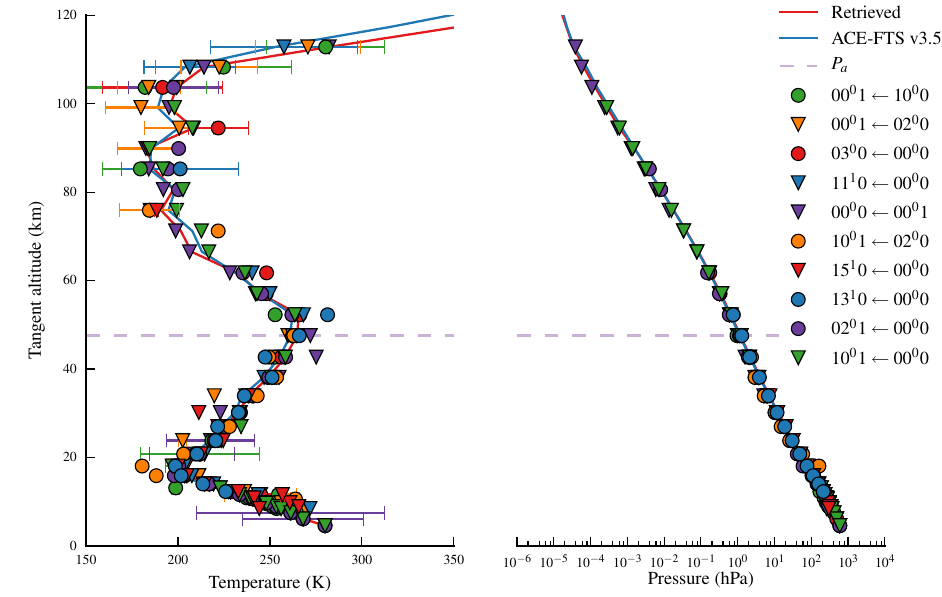
Figure 2. Retrieved T and P using all CO 2 bands at all tangent altitudes for ACE-FTS occultation ss5211. Each marker indicates a band that passed data quality criteria; no bands contribute at every altitude. The retrieved pressure profile (red line) is that computed from Eq. (6) by integrating the retrieved temperature profile above and below P a . The horizontal dashed line indicates the P a